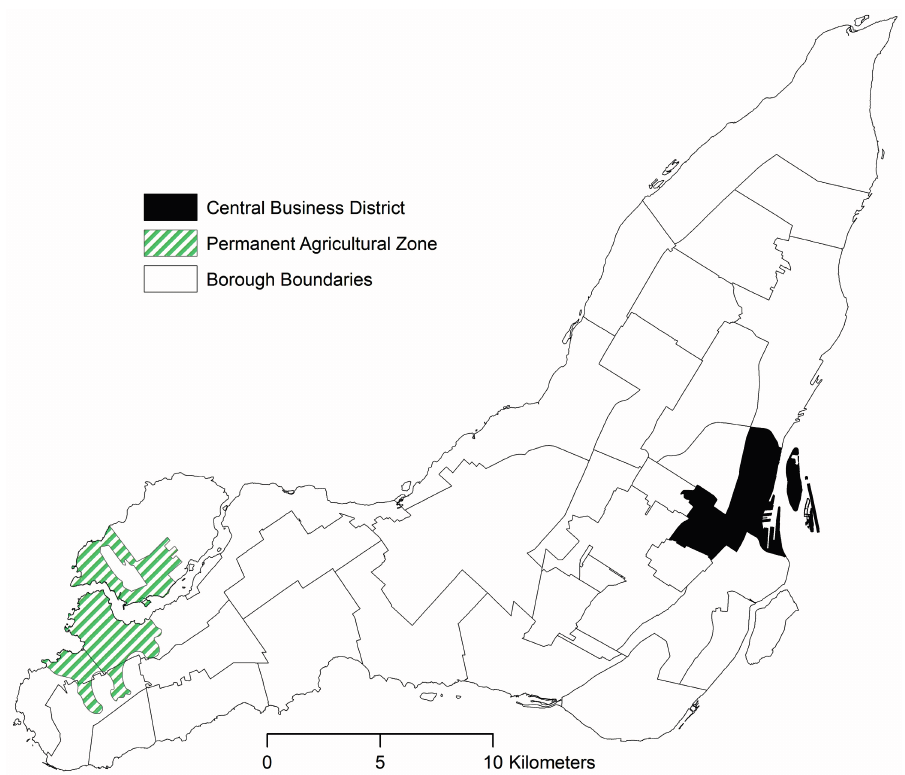
Figure 1. The island of